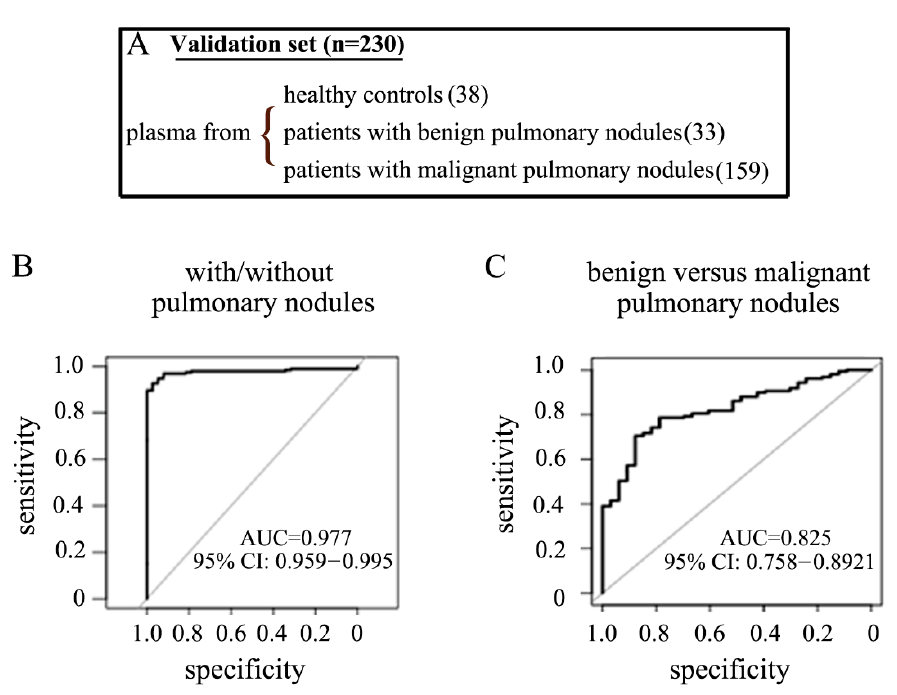
Figure 3. Assay performance in detecting both the existence and the nature of pulmonary nodules in a validation cohort. ( A ) Biospecimens used in the validation cohort. ROC curve for prediction rules in detecting patients with/without pulmonary nodules ( B ) and patients with benign versus malignant pulmonary nodules ( C ).